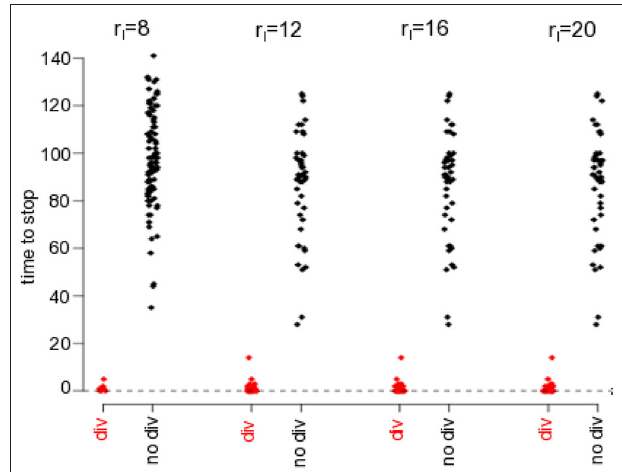
FIGURE 10 | The divergence correlates with the weighted model-observation covariances at observed grid points A o . The plots show the times of maxima T o (cf. Equation 37) to stop, i.e., T stop T o . T o is the time when the mean − model-observation covariance A o is maximum, for divergent (red-colored with break time T stop ) and non-divergent (black colored with maximum time T stop 200) trials. Here it is r H = =